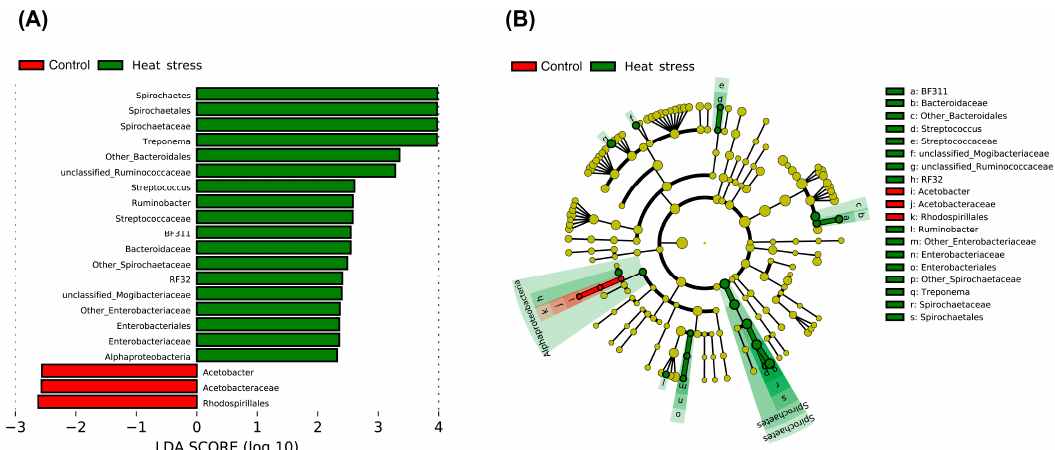
Figure 4. The relative abundant (%) of genera in the rumen of dairy cows with or without heat stress.